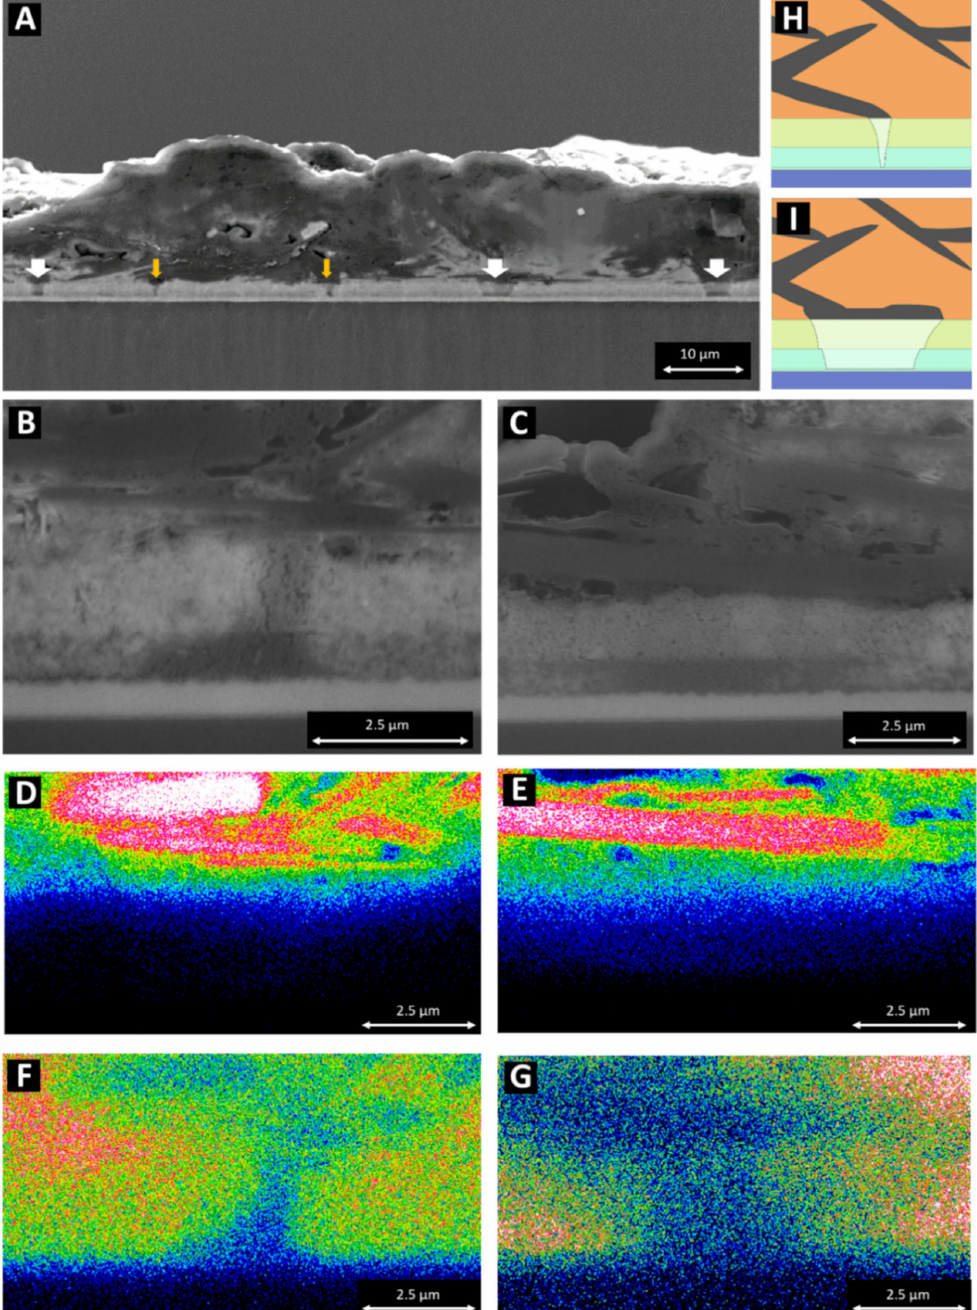
Figure 6. Imaging of pin and plate defects within the mesoporous carbon stack: ( A ) large cross section of a high-performance cell with plate (white arrows) and pin (orange arrows) defects identified; ( B , C ) close-up of a pin and a plate defect, respectively; ( D , E ) EDS carbon intensity map of a pin and a plate defect, respectively; ( F , G ) EDS lead intensity map of a pin and a plate defect, respectively; ( H , I ) simplified schematics of the pin and plate defects,